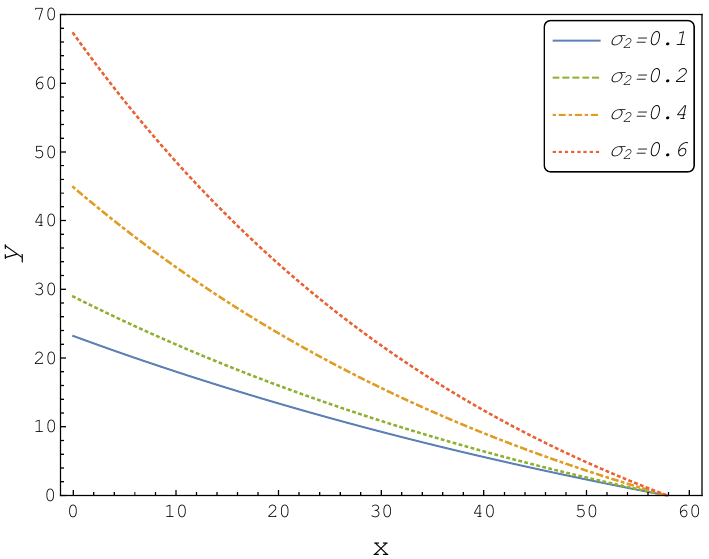
Figure 2. The numerical threshold boundary for the following set of parameter values: σ 1 = 0.2, α 1 = 0.02, α 2 = 0.02, r = 0.1, ρ = 0, Q 1 = 5, Q 2 = 10, I = 2000 and different values of σ 2 .